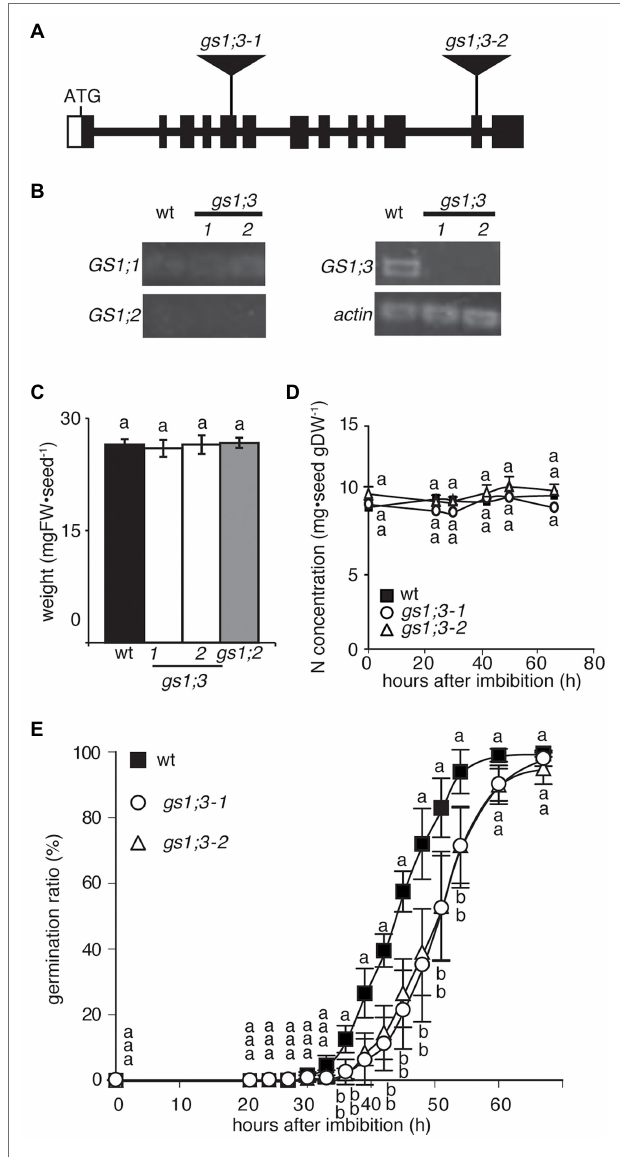
FIGURE 2 | Loss of function of GS1;3 retarded seed germination in rice. (A) Schematic representation of the positions of Tos17 insertions in gs1;3-1 and gs1;3-2 mutants. Filled box indicates exon, and line indicates intron. Opened box indicates untranslated region. (B) Semi-quantitative RT-PCR analysis (30 cycles) of GS1 isoforms and actin in mature WT and GS1;3 mutant seeds. (C) Weight and (D) N concentration of mature WT, GS1;2 and GS1;3 mutant seeds. Each data point represents mean ± SD ( n = 5–10 seeds). (E) Germination time course analysis of WT and GS1;3 mutants. During 20– 72 h after imbibition, the ratio of germinated seeds was calculated every 3–6 h. Fifty seeds per line were analyzed during this period, and the experiment was repeated three times ( n = 3 with 50 seeds each). The data represent the mean of 3 experiments ± SD. Significant differences within each group were determined using one-way analysis of variance (ANOVA) followed by Bonferroni tests and are indicated with different letters ( p <